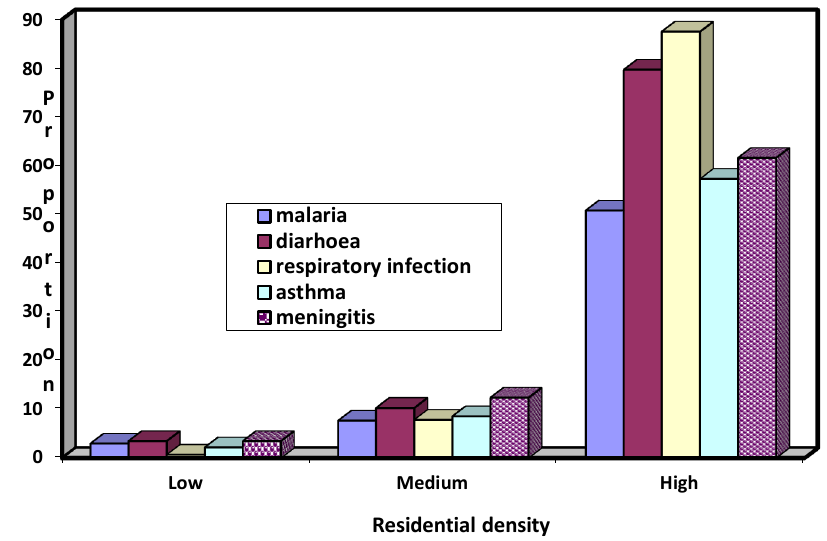
Figure 5. Intracity variations in incidence of most prevalent